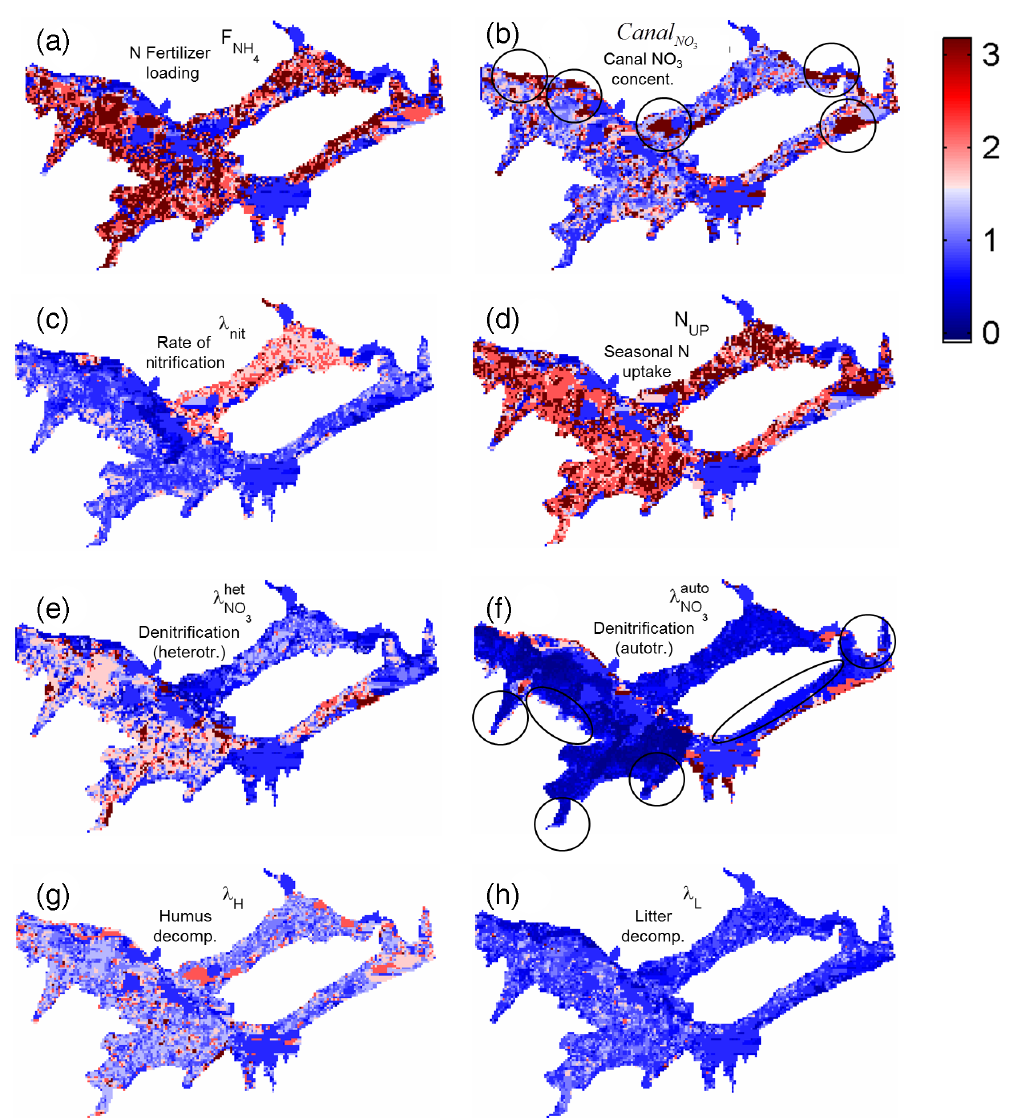
Figure 9. Cell-by-cell (250m by 250m) plots of Savage scores for (a) F NH and (h) λ L , indicating the ranking of influence of that parameter on C NO